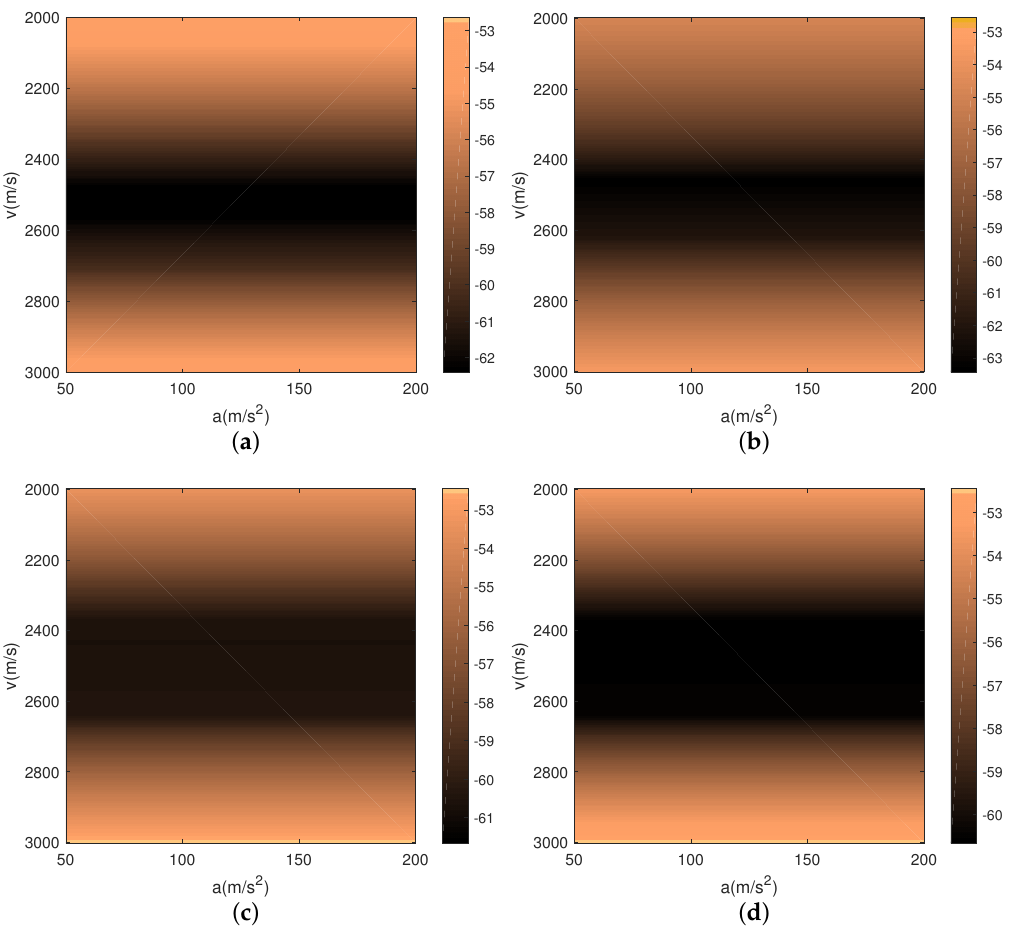
Figure 3. The PSL and I of the sequences designed by the IAG algorithm (dB). ( a ) The PSL of r HH, l under different motion states; ( b ) The PSL of r VV, l under different motion states; ( c ) The I of r HV, l under different motion states; ( d ) The I of r VH, l under different motion states.